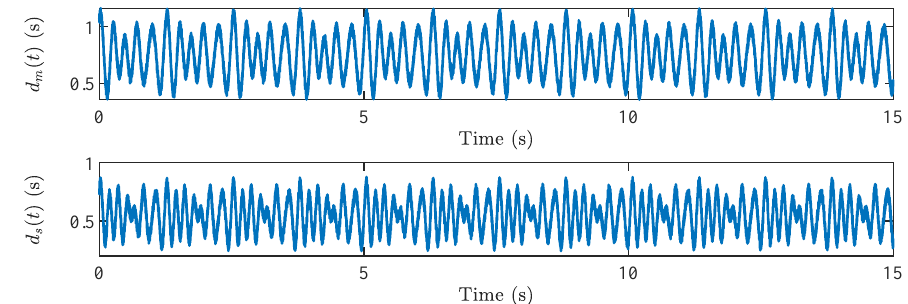
Figure 2. The time-varying communication delays d m and d s .